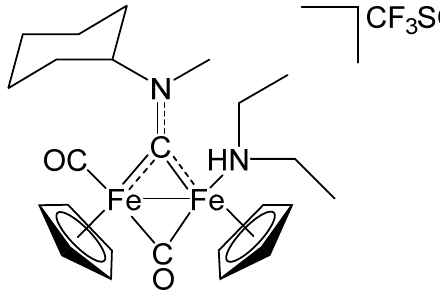
Figure 7. Structure of 4b.